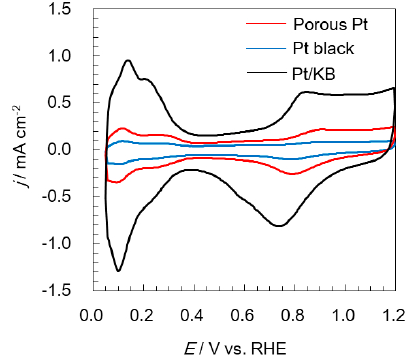
Figure 3. Cyclic voltammograms of porous Pt, Pt black, and Pt/ketjen black (KB).